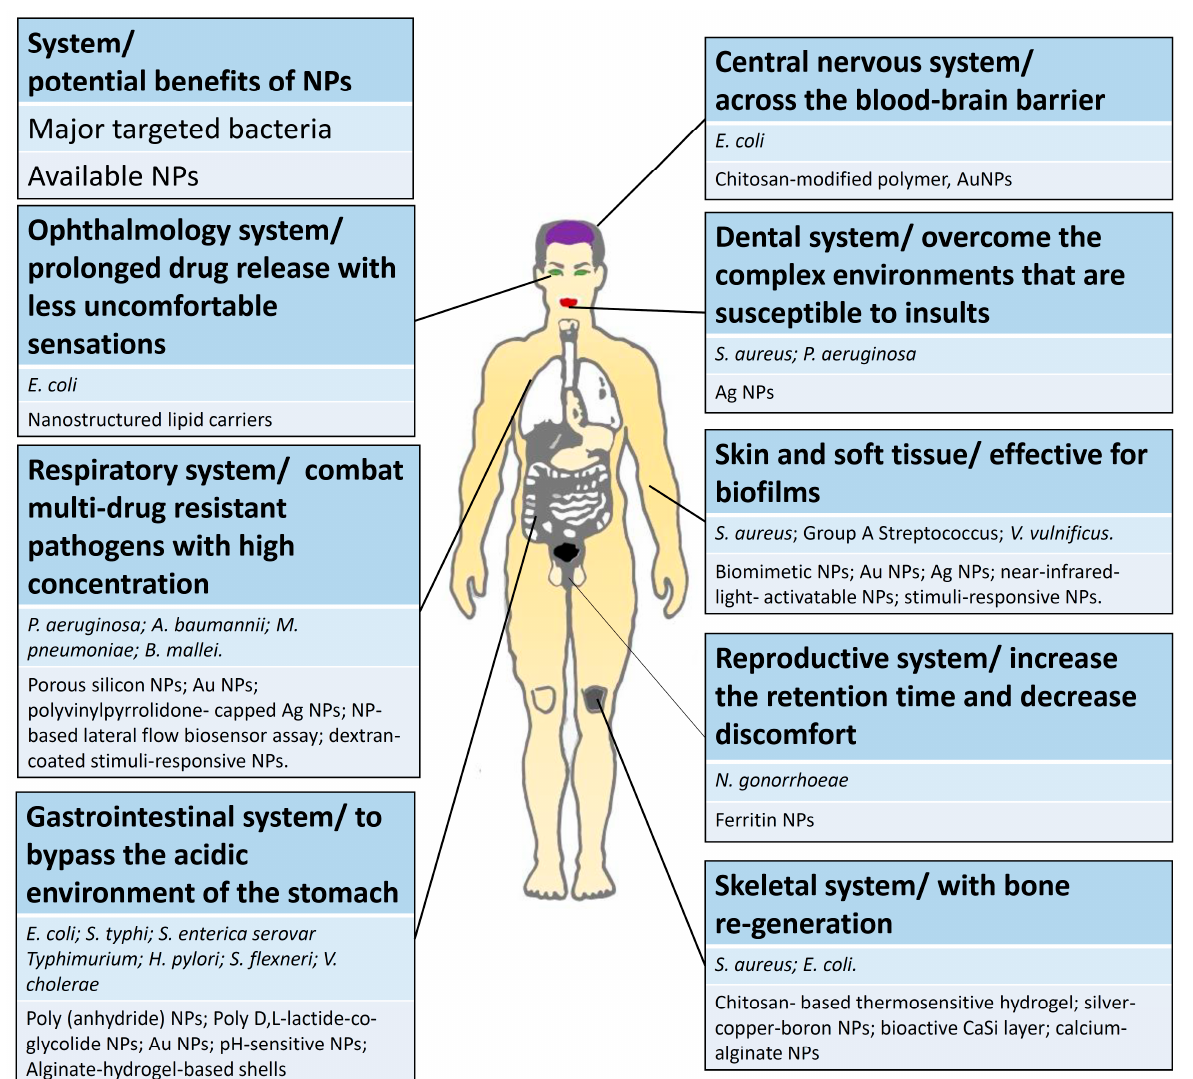
Figure 3. Advances in the use of NPs to treat bacterial infectious diseases in different body systems.